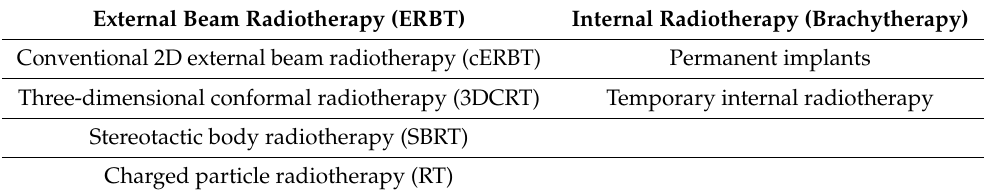
Table 3. Classification of the available RT modalities [3,25]